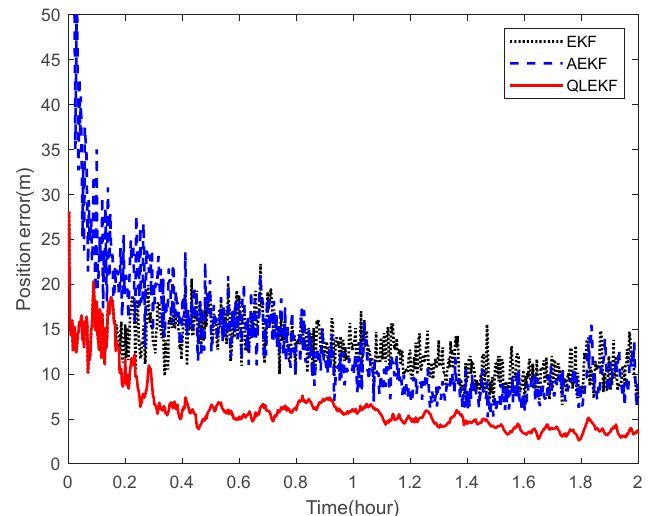
Figure 17. RMSE of the position estimation for EKF, AEKF and QLEKF.